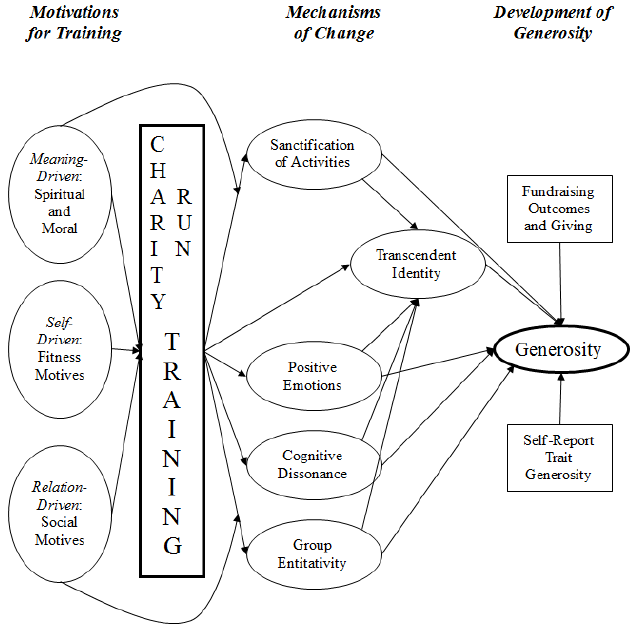
Figure 1. Theoretical model predicting generosity in the context of marathon participation.